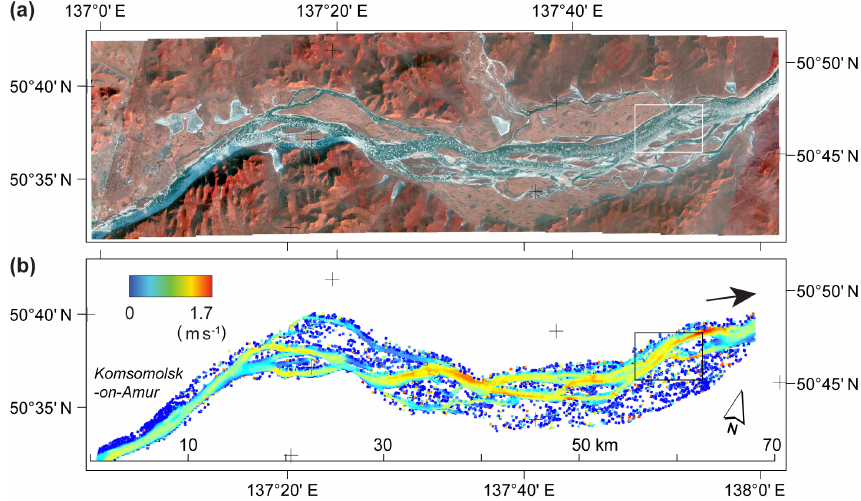
Figure 5. Amur River near the city of Komsomolsk-on-Amur, Siberia (lower left corner). River surface velocities on 1 November 2016 are tracked over a 73s time lag between overlapping Planet cubesat images. (a) A false colour composite of one of the image strips, and (b) the derived surface speeds. The overall flow direction is from left to right. The small rectangle marks the location of the detailed image shown in Fig.